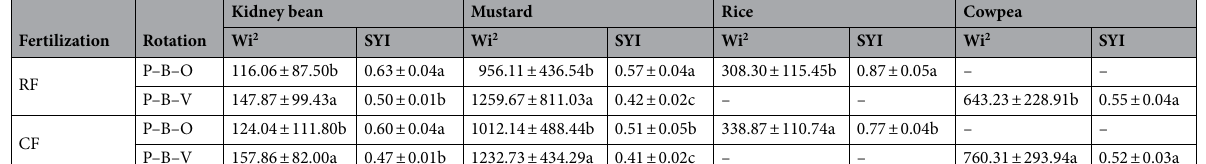
Fertilization Rotation Table 6. Crop stability indexes and sustainability indexes for different treatments. Different lowercase letters indicate signifcant difference between treatments (P < 0.05).